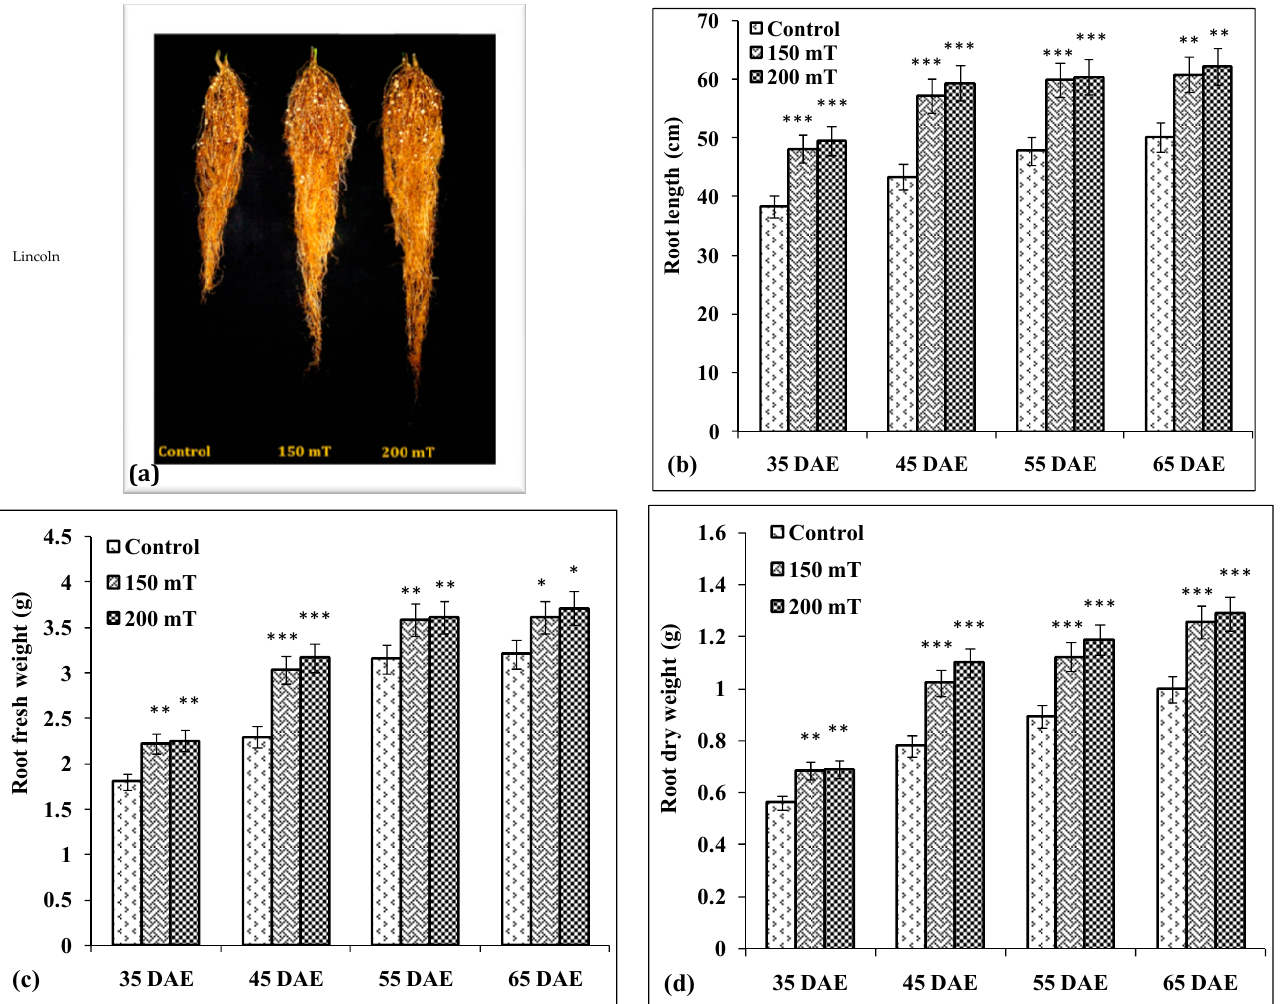
Figure 14. Effect of pre-sowing magnetic field treatment of soybean seeds on root growth at 45 DAE ( a ), root length ( b ), root fresh weight ( c ), and root dry weight ( d ) at different growth stages. ***, ** and * indicate significance at p < 0.001, 0.01 and 0.05, respectively, compared to control.